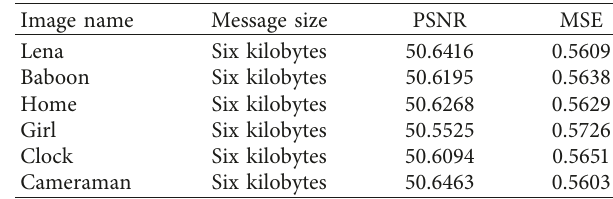
Table 4: Performance analysis of the proposed method using (256 256) images. ∗